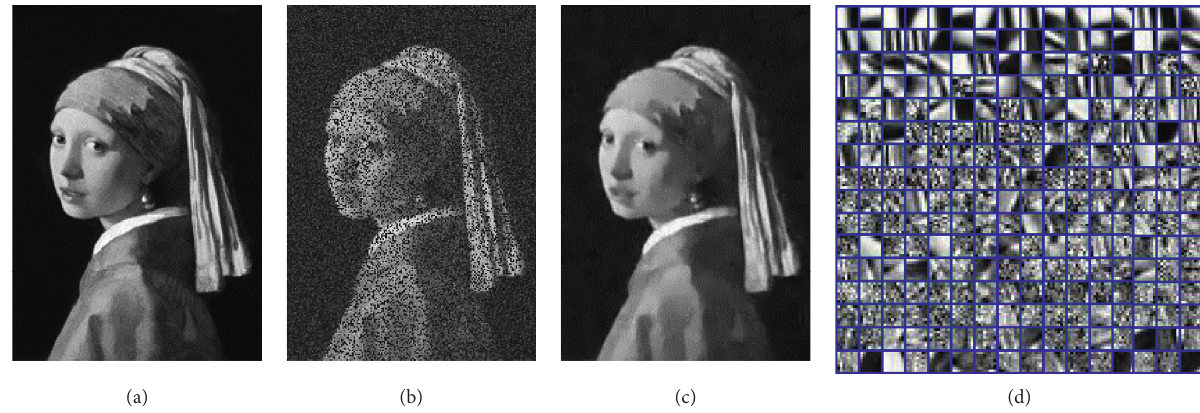
Figure 4: An example of applying the KSVD method to restore the damaged image. (a) Original image of the painting “Girl with a Pearl Earring” by Johannes Vermeer. (b) Damaged image containing 25% missing pixels has PSNR � 13.77dB. (c) Reconstruction result using the KSVD method has PSNR � 31.56 dB. (d) The updated/learned dictionary. Each patch represents a column vector or an atom of the dictionary matrix D